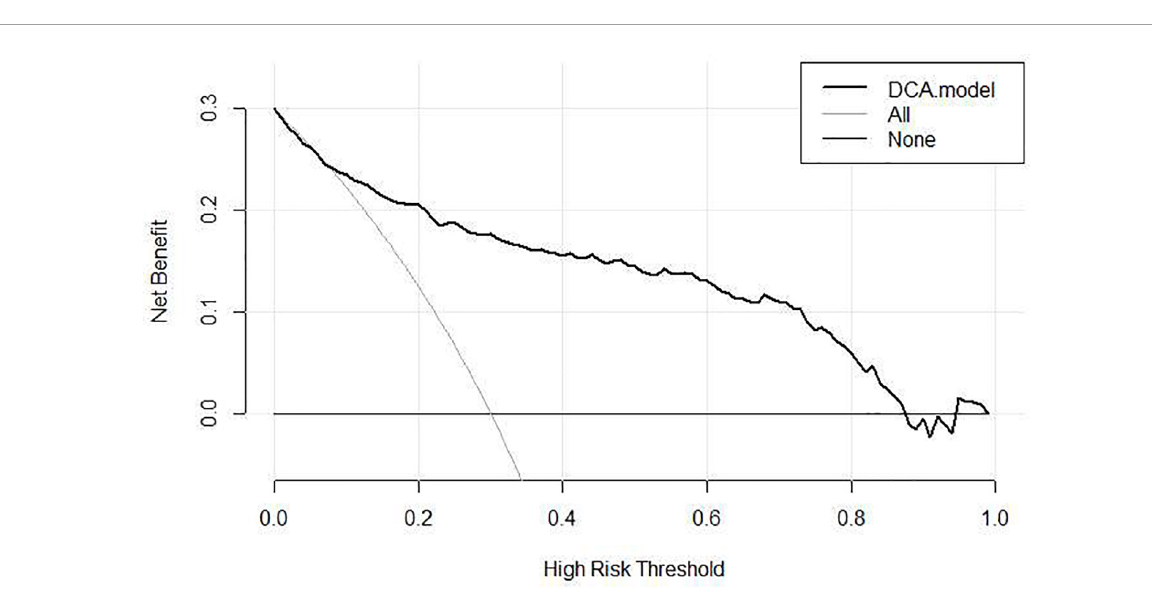
FIGURE5 DCA of the